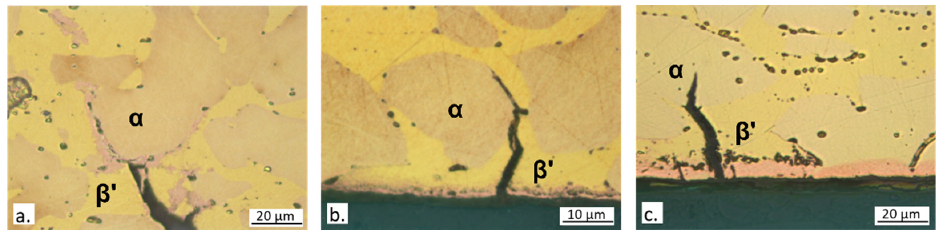
Figure 13. Optical micrographs of sections of CW617N specimens after SSRT in SDW solutions containing ( a ) 100 ppm; ( b ) 400 ppm; and ( c ) 700 ppm chlorides.